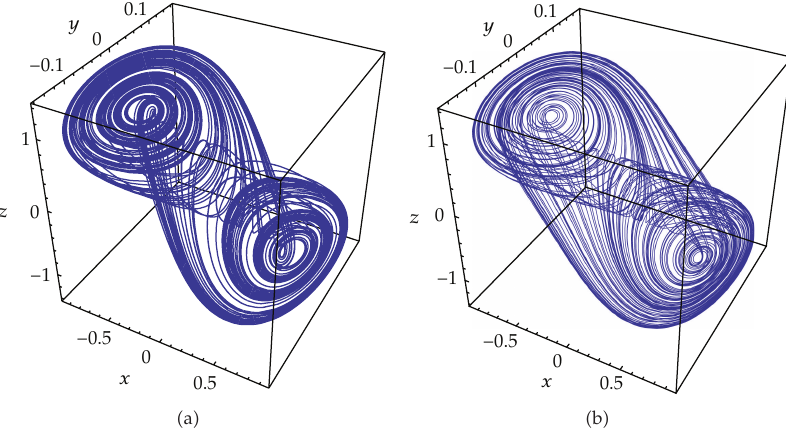
Figure 4: Phase plot of Chua-Hartley’s chaotic attractor in the x - y - z space: (cid:3) a (cid:4) q 1 (cid:7) q 2 (cid:7) 0 . 92, q 3 (cid:7) 0 . 86, (cid:7) 0 . 90, q (cid:7) 0 . 89, q (cid:7) 0 . 86, α (cid:7) 12 . α (cid:7) 12 . 75, (cid:3) b (cid:4) q 1 2 3